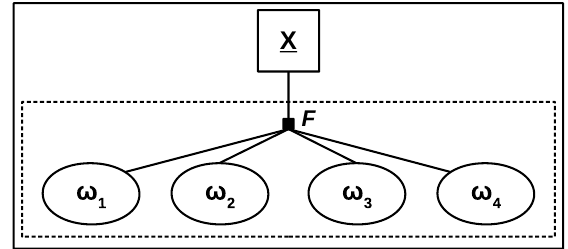
Figure 1. Traditional multi-class classification for a four-class problem. A feature vector x is assigned to one of the four classes ω j in a single decision, using the feature set F